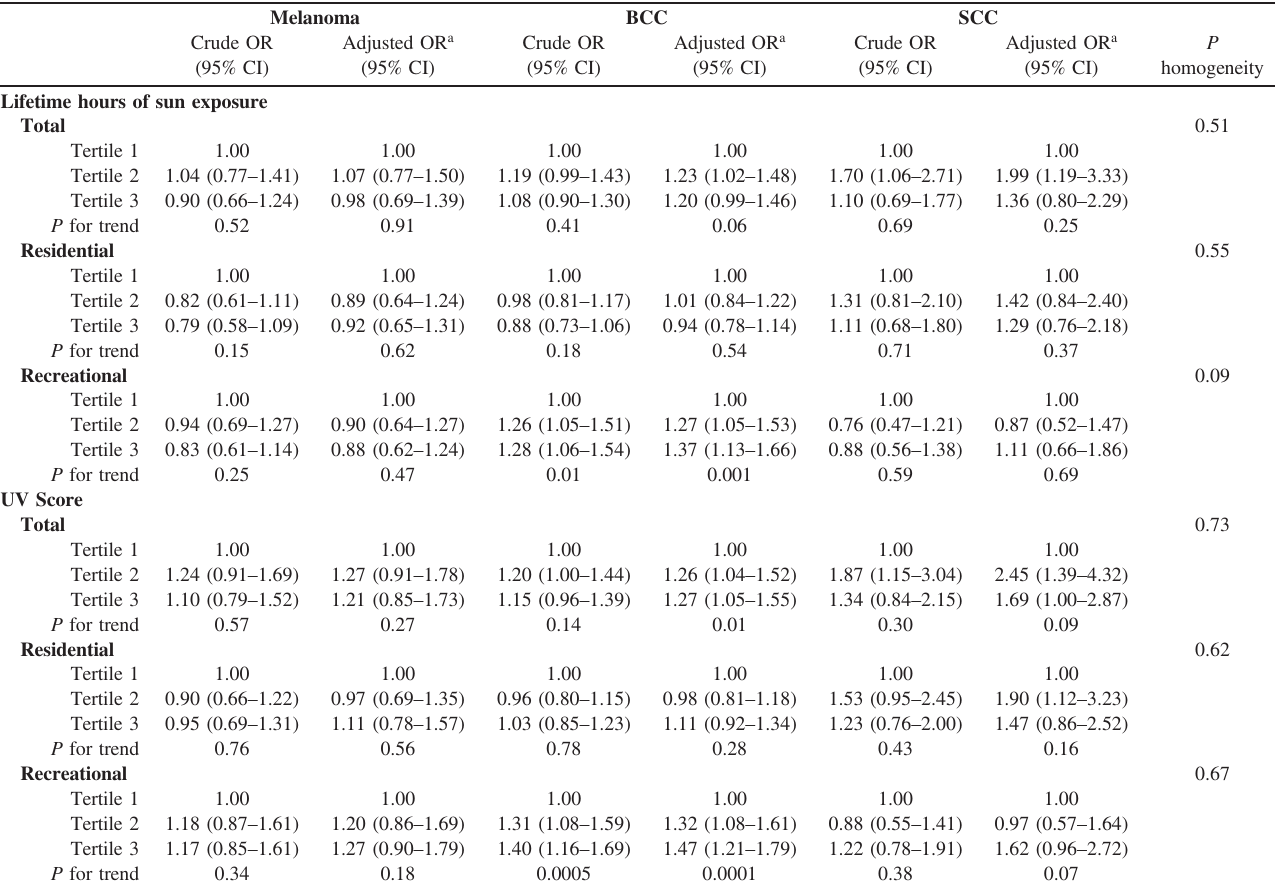
Table 2. Crude and adjusted ORs for risks of melanoma, BCC and SCC associated with lifetime hours of sun exposure and UV score ( n = 5,783)